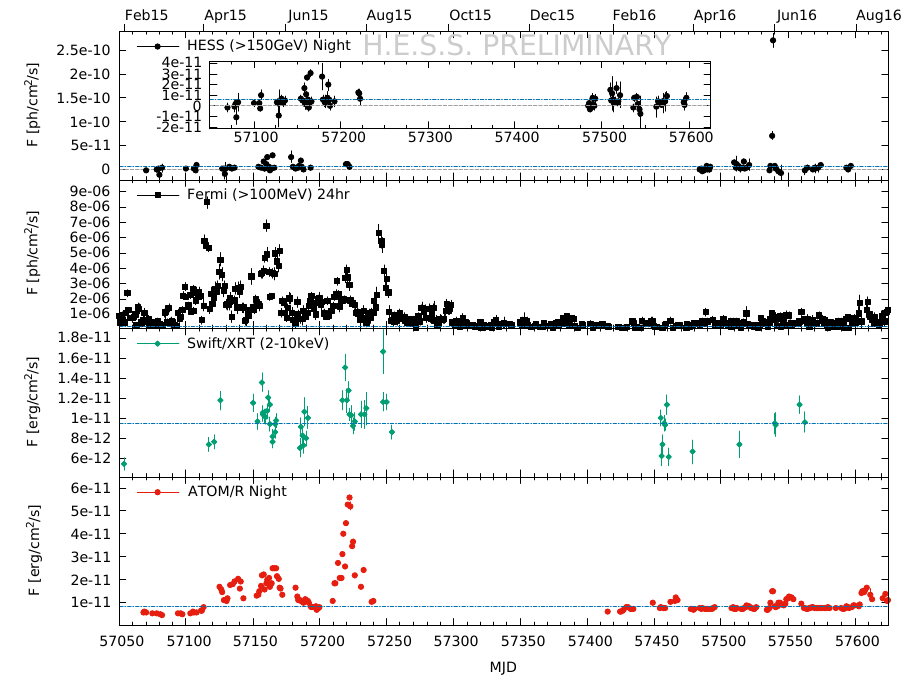
Figure 2. Nightwise binned fluxes from 2015 to 2016 in the VHE band taken with H.E.S.S. (1st panel), the HE band taken with Fermi -LAT (2nd panel), the X-ray band taken with Swift -XRT (3rd panel), and the optical R-band (4th panel). The inset shows a zoom in on VHE fluxes without the 2016 flare. The blue dash-dotted line marks the average flux, while the gray dashed line marks the zero-flux